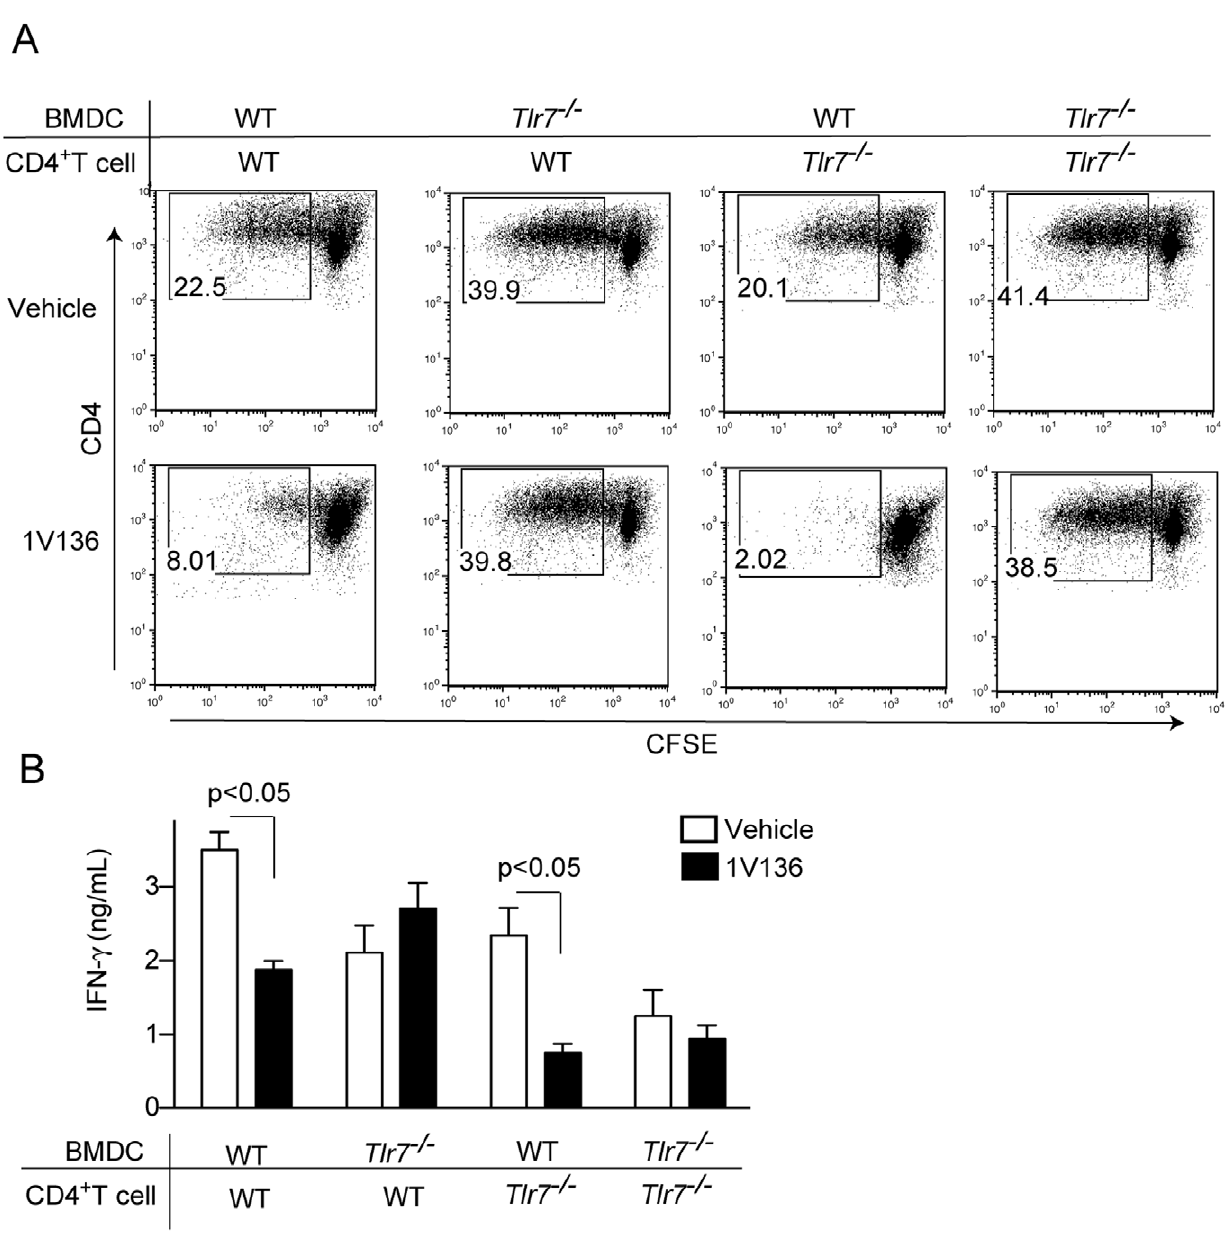
Figure 2. TLR7 ligand treatment selectively impaired dendritic cell and not T cell function. (A) CFSE-labeled CD4 + T cells were prepared from WT or Tlr7 2 / 2 mice immunized with OVA/CFA. WT or Tlr7 2 / 2 BMDCs were incubated with these primed CD4 + T cells with OVA (100 m g/mL) in the presence or the absence of 1V136 (1 m M) for five days. T cell proliferation was monitored by flow cytometry. Representative plots are shown from three experiments. (B) The culture supernatants were assessed for IFN- c levels by ELISA. The data shown are representative of two independent experiments. p , 0.05 by Student t test compared to vehicle control.